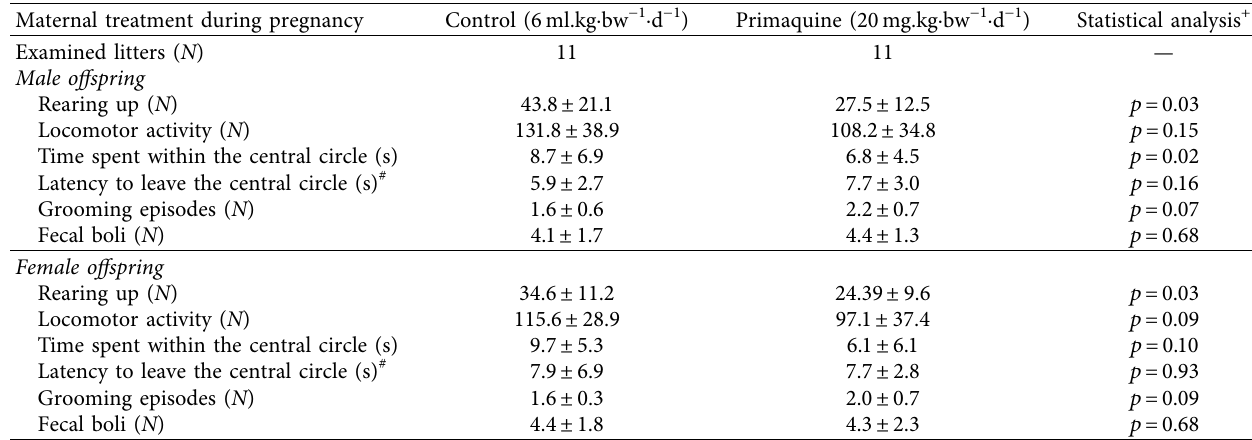
Table 4: Exploratory behavior (open field test) of the offspring of female rats treated orally with primaquine during pregnancy (GD 0–21) on postnatal day 25.